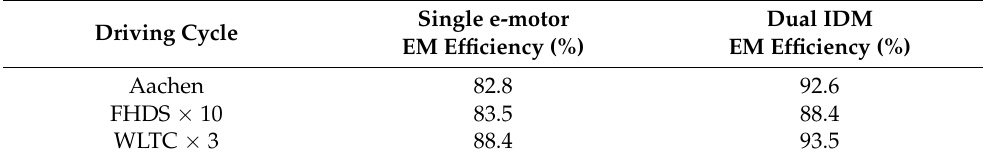
Table 5. E-motor average efficiency.